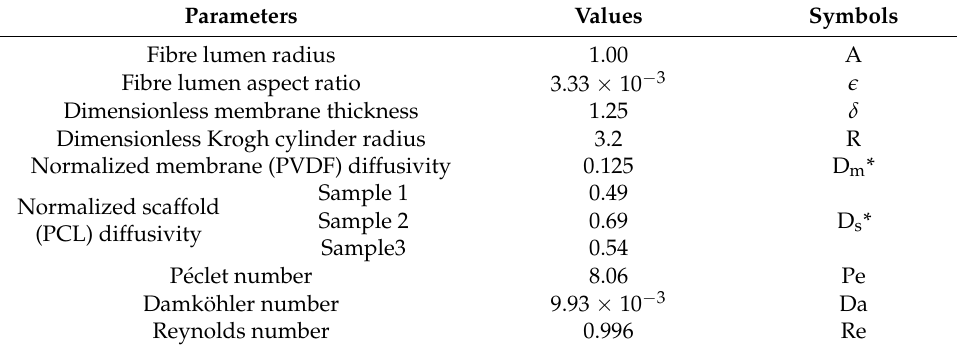
Table 9. Dimensionless variable used in mathematical modelling. Parameters Values Symbols Fibre lumen radius 1.00 A Fibre lumen aspect